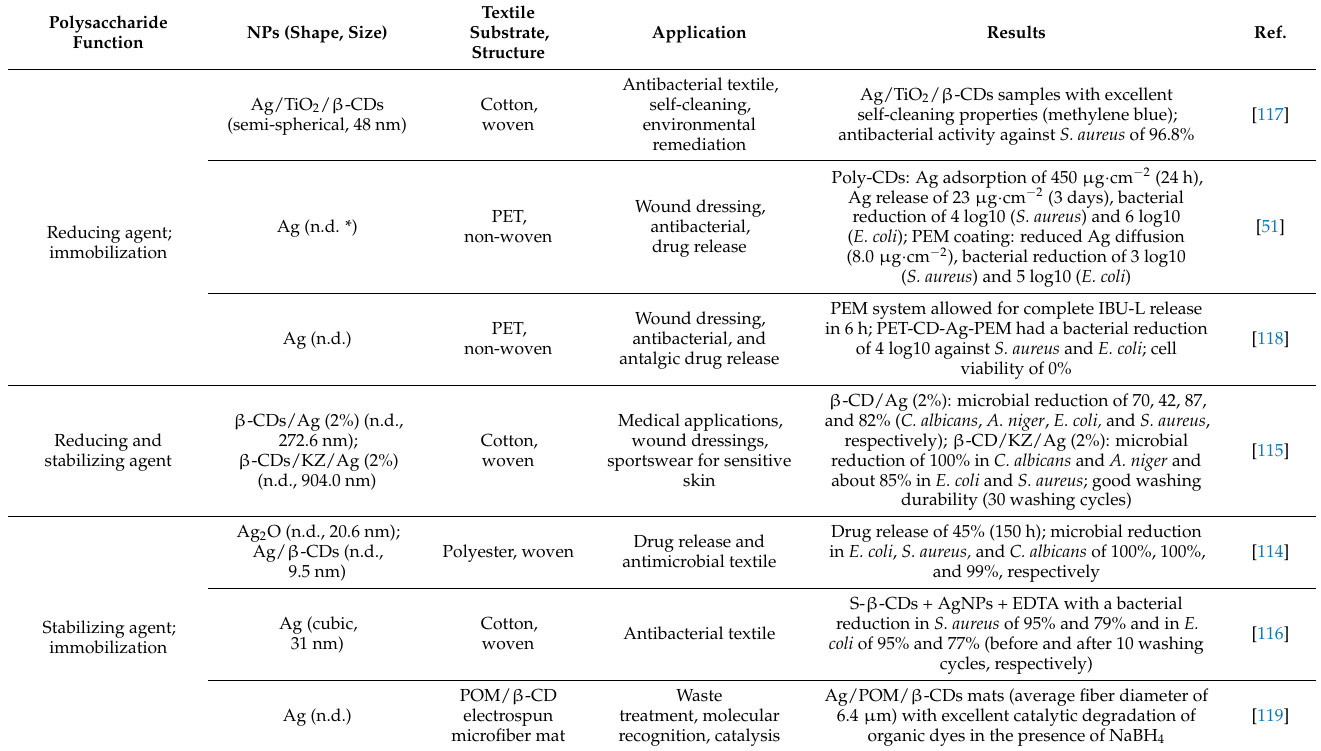
Table 4. Textile materials functionalized with cyclodextrins and metal nanoparticles. Polysaccharide function towards